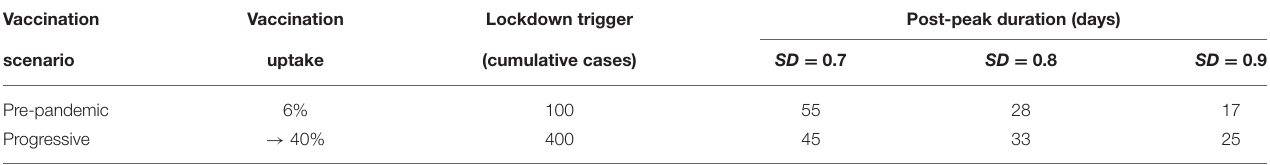
TABLE 2 | Comparison of control measures: projected lockdown duration after the incidence peak, until new cases fall below 10 per day. Vaccination Vaccination Lockdown trigger Post-peak duration